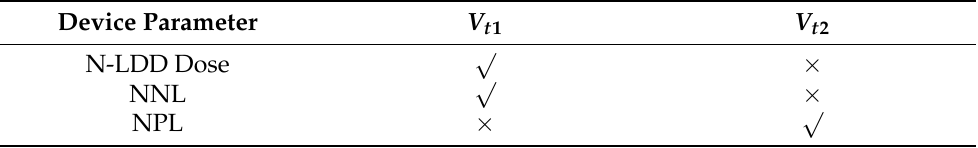
Table 4. Summary of ESD performance with different device